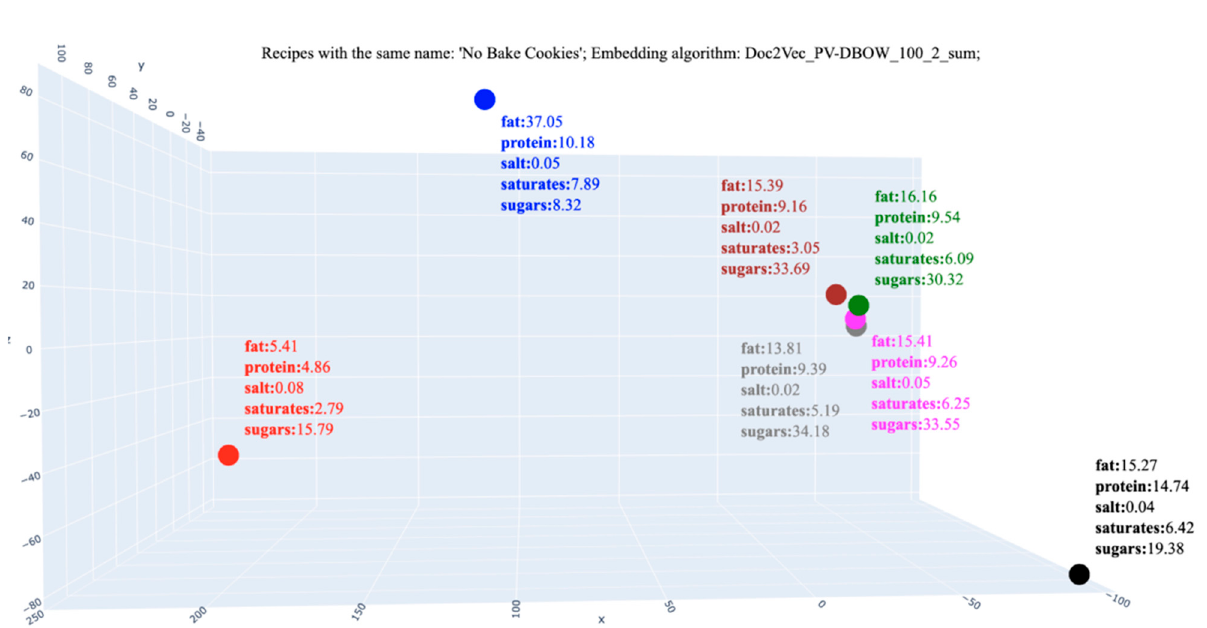
Figure 4. Visual representation of the vector representations with the domain-specific heuristic of a group of recipes with the same name.